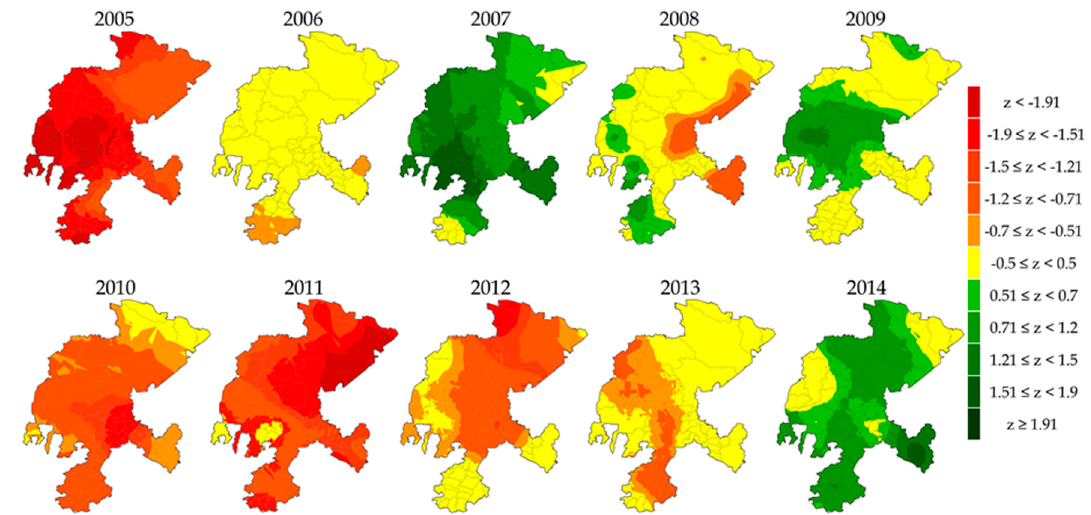
Figure 3. Three ‐ month timescale Standard Precipitation Index (April–June).